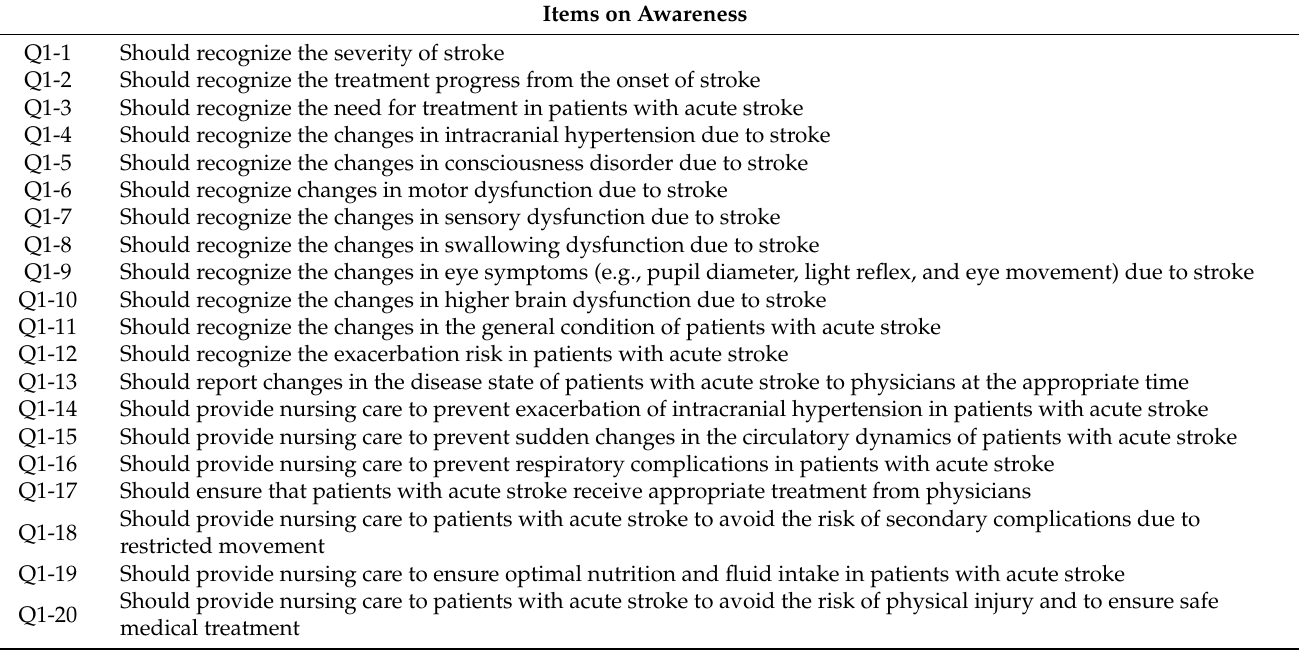
Table A1. Questionnaire Items on Awareness of the Need for Nursing Care for Patients with Acute Stroke versus the Actual